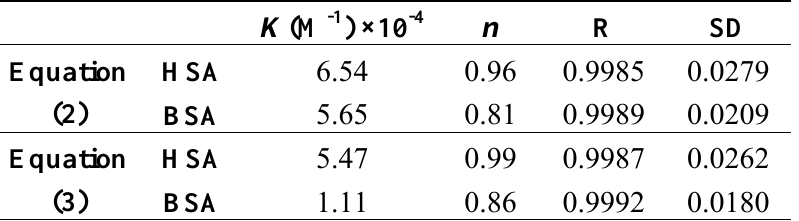
Table 1 . Binding parameters (binding constants, K, and number of binding sites, n) characterizing the HEBID-HSA and HEBID-BSA interactions, estimated in the d/p range